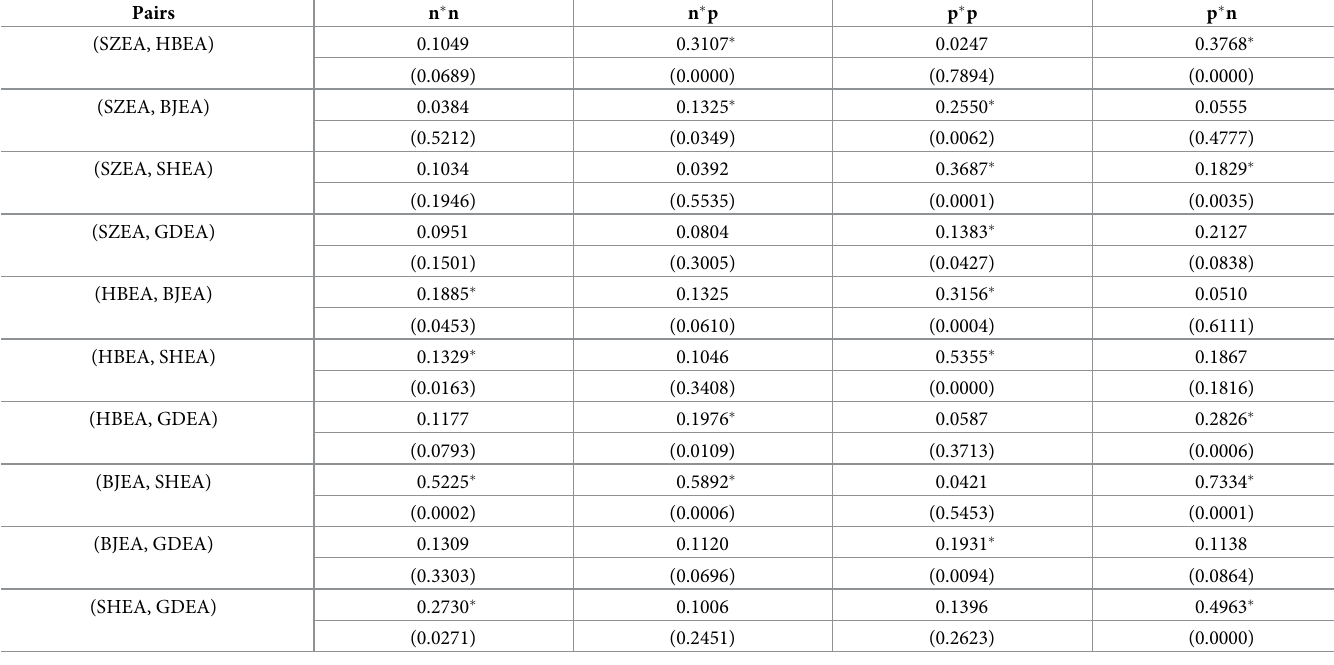
Table 8. Tail dependence test result: Among China’s carbon